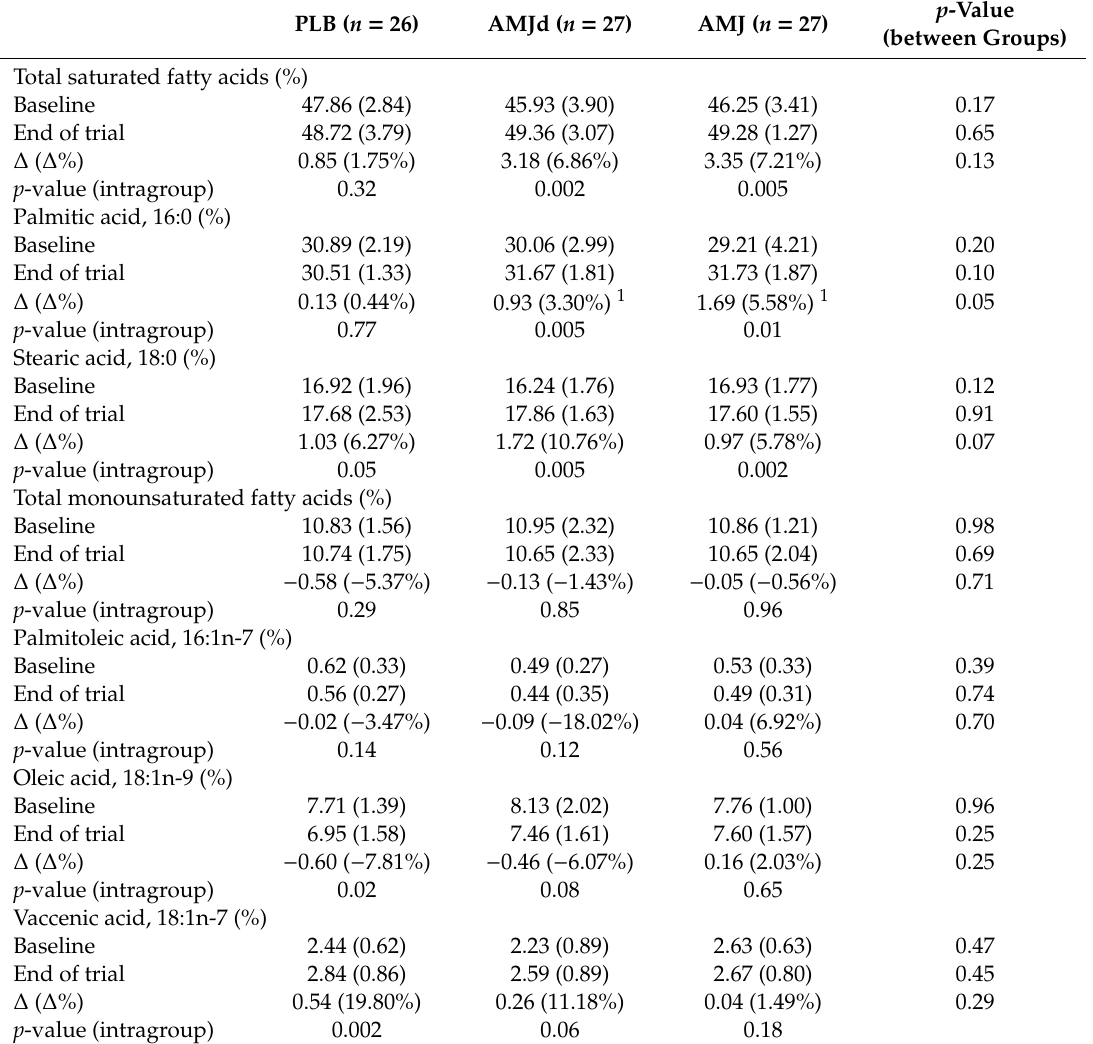
Table 3. Changes in the levels of saturated (SFA) and monounsaturated (MUFA) fatty acids following daily intervention for four weeks with the placebo (PLB) drink, the polyphenol low-dose chokeberry juice (AMJd) and the polyphenol high-dose chokeberry juice